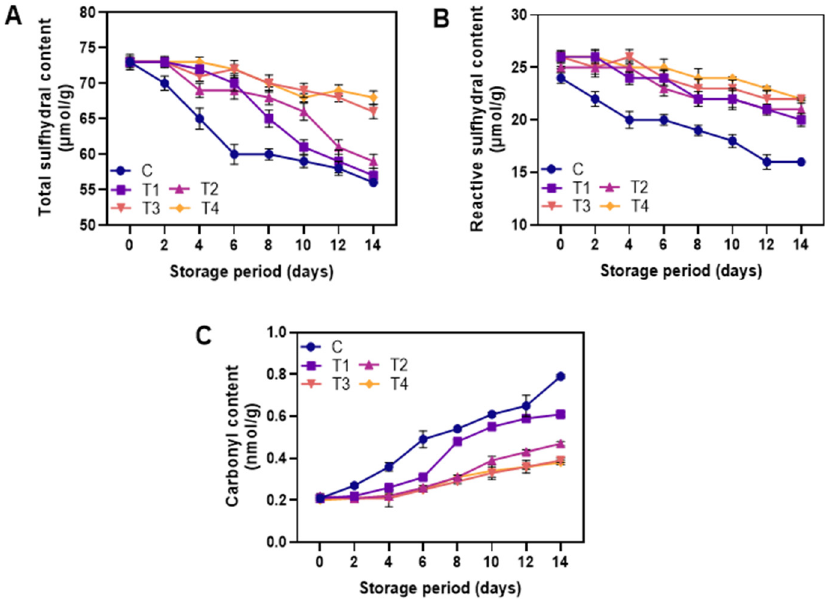
Figure 6. Changes in total sulfhydral content ( A ), reactive sulfhydral content ( B ), and carbonyl content ( C ) of the shrimps coated with different coatings during storage of 14 days at 4 ◦ C. C: shrimp dipped in distilled water as control; T1: shrimp coated with alginate coating; T2, T3, and T4: shrimp coated with 0.5, 1.0, and 1.5% LPE,